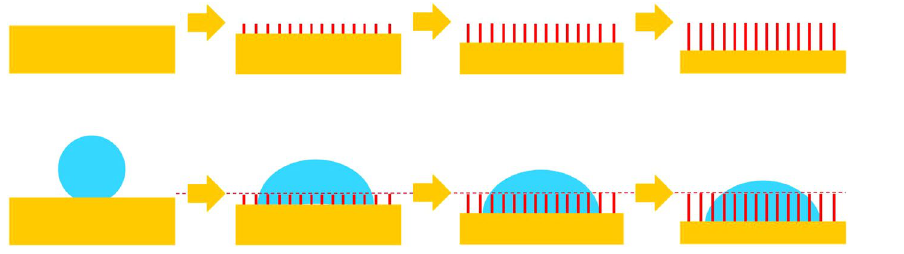
Figure 10. Schematic of wetting evolution